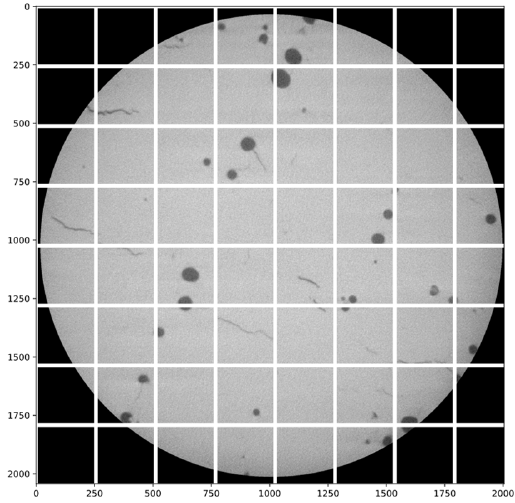
Figure 8. The 256 × 256 patches used as training set (number of patches: 64).